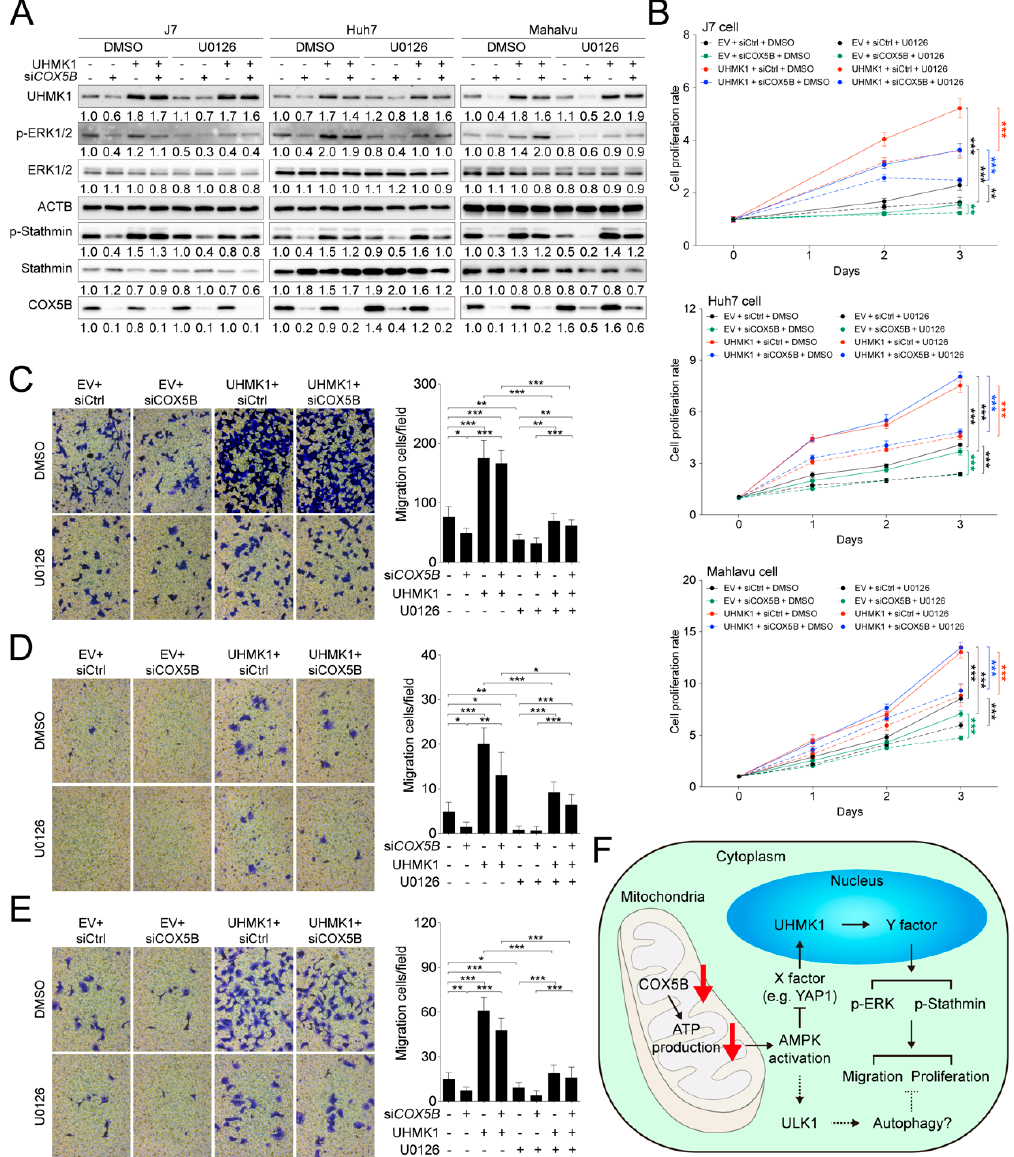
Figure 8. The COX5B-UHMK1-ERK cascade regulates hepatoma cells proliferation and migration. ( A ) The western blot analysis of the phosphorylation status of ERK and Stathmin with or without the treatment of ERK inhibitor U0126 in hepatoma cells. The western blot images in ( E ) were all acquired by using chemStudio PULS imaging system. ( B ) The cell proliferation curves of hepatoma cells receiving the indicated treatments. The transwell-based assays to examine cell migration ability under the indicated treatments in ( C ) J7, ( D ) Huh7 and ( E ) Mahlavu cells (left panel). The quantitative results were shown in right panel. The p value was derived from paired two-tail student t -test. *, p < 0.05; **, p < 0.01; ***, p < 0.001. All the in vitro cell-based assays shown in this figure were conducted in duplicates. ( F ) The schematic depiction summarizing the key findings of this study. X and Y indicated the unknown factors involved in the regulatory events downstream of COX5B. The dotted lines indicated possible routes affected by COX5B, which remained to be characterized in the future.